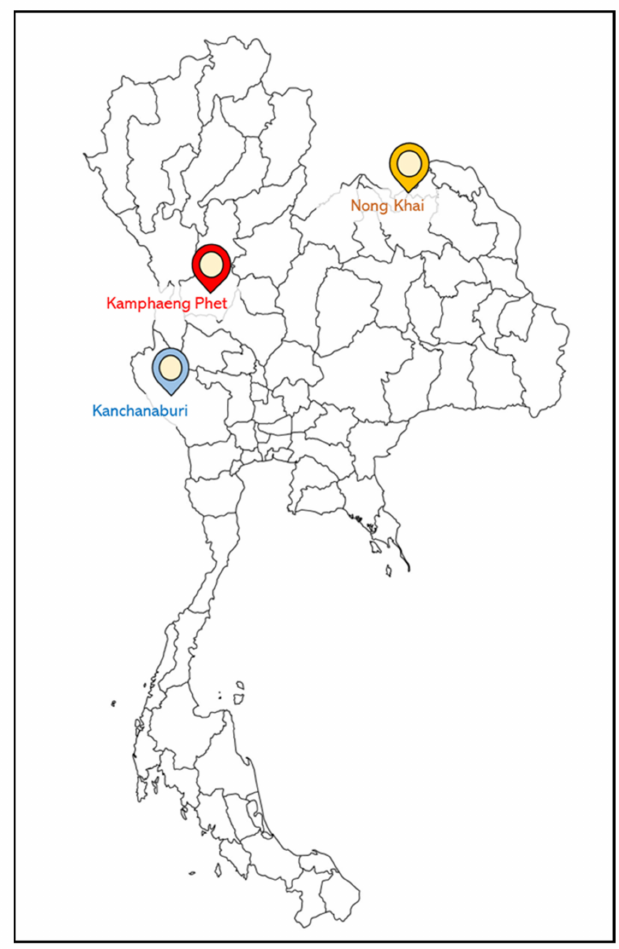
Figure 1. Three different locations of vaccine field trials in Thailand: north (Kamphaeng Phet province), northeast (Nong Khai province) and west (Kanchanaburi province).